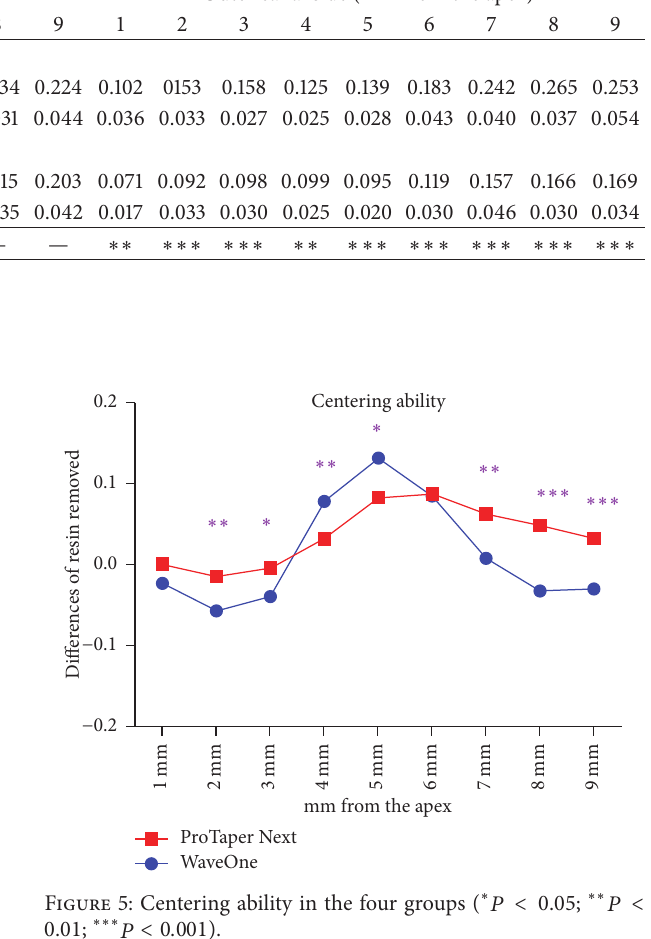
Table 1: Analysis of the amount resin removed from the inner and outer aspect of the canal at nine-point level from the apex. Inner canal side (mm from the apex) Outer canal side (mm from the apex)